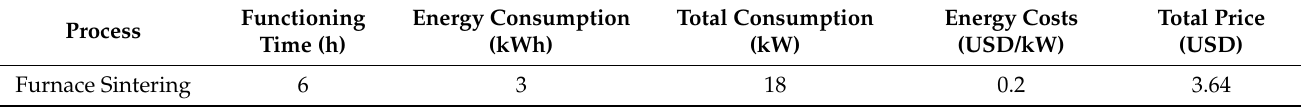
Table 4. Furnace sintering process costs for the HEA